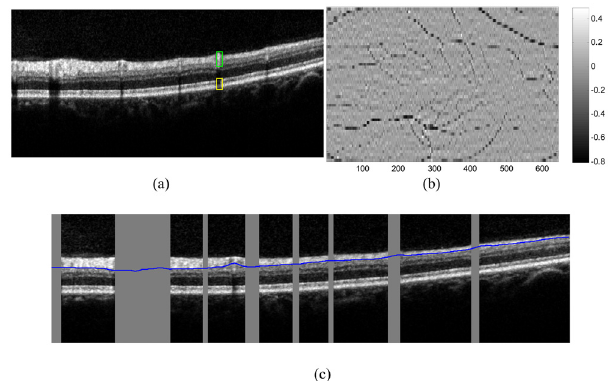
Fig 7. Detection of A-scans affected by retinal blood vessels. (a)The shadowing effect from the retinal blood vessels is more pronounced near the RPE (yellow rectangle, note the hypo reflective regions) and less pronounced near the ILM (green rectangle). (b) An example of the enface map of a macular volume OCT. (c) The result of RNFL o detection (blue solid line). The regions where the A-scans are affected by the blood vessel shadowing is highlighted with gray